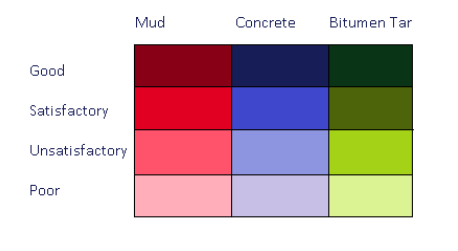
Figure 3. Legend for different